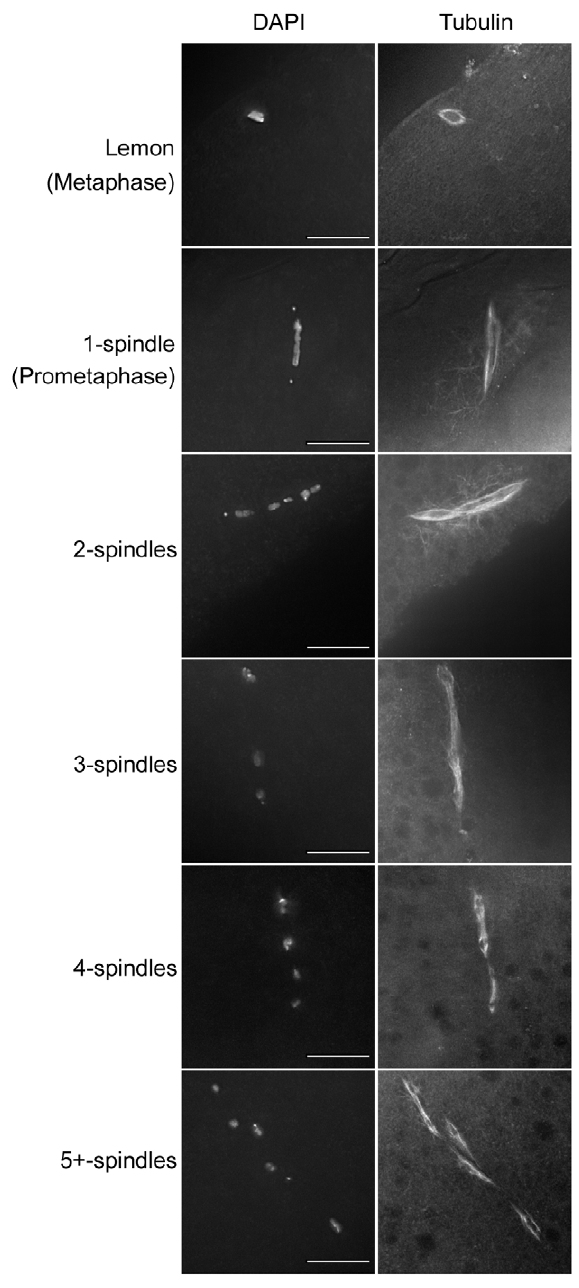
Figure 7. X-rays partially rescue prometaphase and metaphase I spindle defects associated with the trem F9 mutation. Images are maximum intensity projections of the optical sections through the tubulin staining region. Meiotic figures are stained with DAPI and tubulin, shown in gray scale. Shown are representative images from trem F9 oocytes. All images are from non-X-ray treated trem F9 females with the exception of the 3-spindle image which is from X-ray treated trem F9 females. Note that 1-spindle images in trem F9 oocytes did not necessarily have the proper DNA configuration as is seen in wild type. See Table 7 for quantification. Scale bar, 15 m